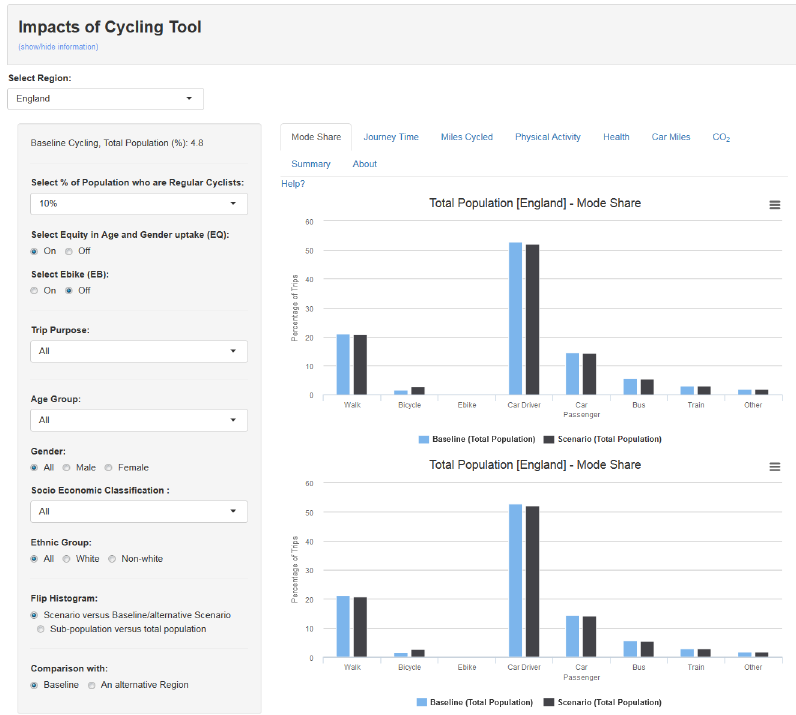
Fig 2. Impacts of cycling tool online